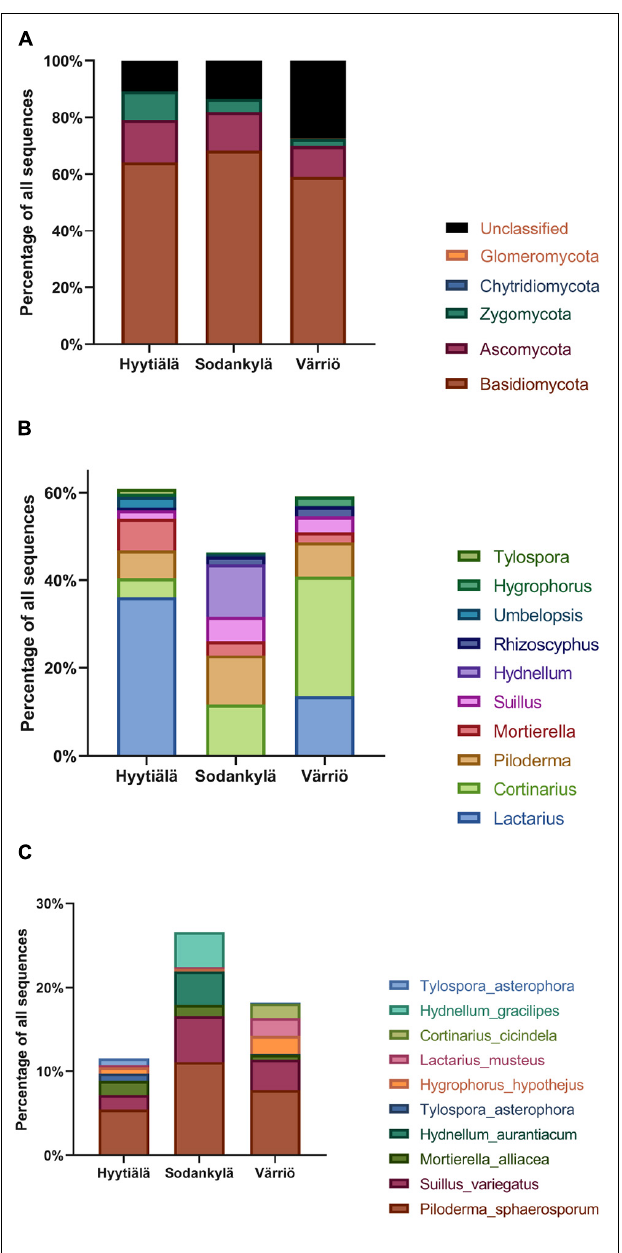
FIGURE 2 | The fungal abundance at different taxonomic levels. (A) Phylum, (B) genus (the top 10 most abundant), and (C) species (the top 10 most abundant) in the three locations between Hyytiälä (southern), Sodankylä (northern) and Värriö (subarctic) boreal pine forests.